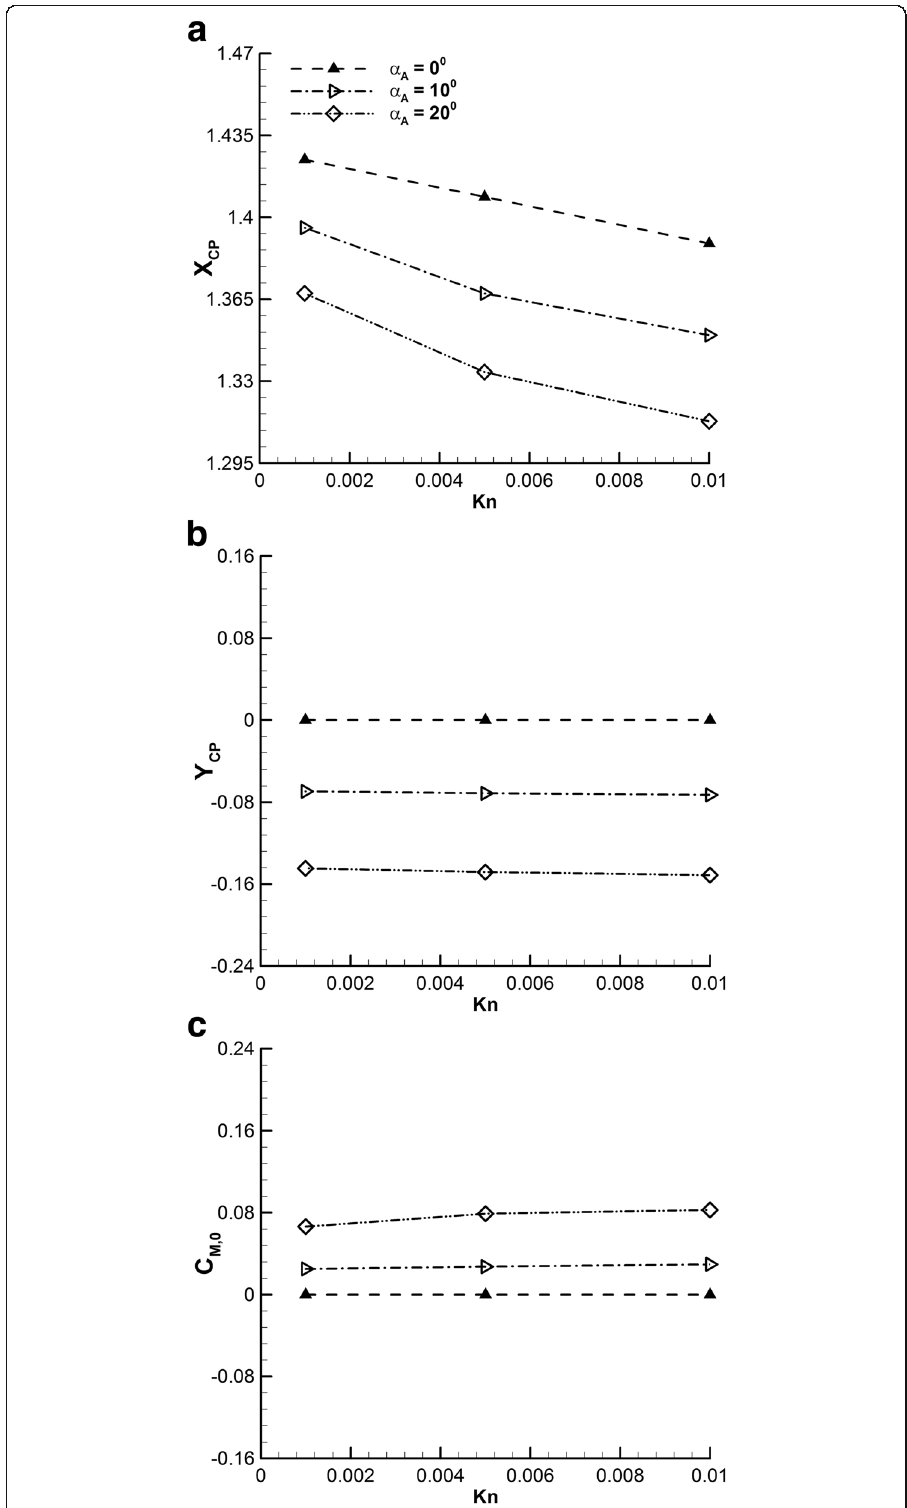
Fig. 23 Comparison of the center of pressure and the pitching moment coefficient for varying Knudsen numbers (0.001, 0.005, and 0.01) for different freestream angles of attack, at M = 6: a X coordinate location of the center pressure, b Y coordinate location of the center pressure, and c pitching moment